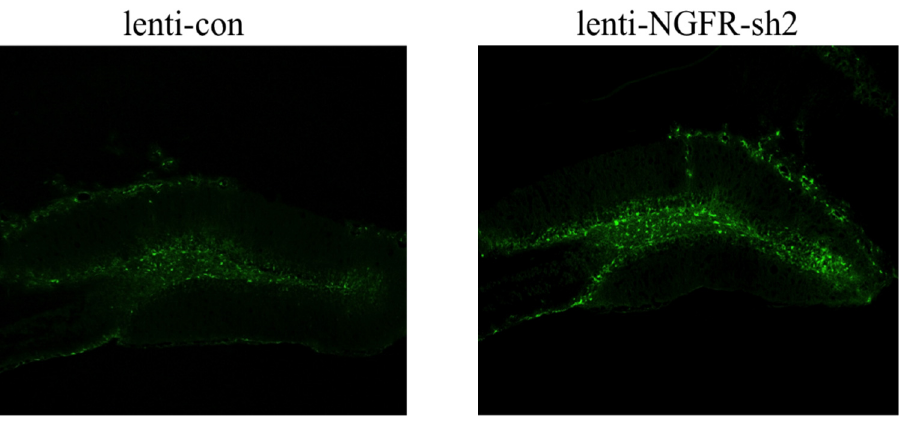
Figure 3. Down-regulation of NGFR in mouse hippocampus. ( A ) Lenti-NGFR-sh2 or control virus was injected into the dentate gyrus of adult mice. Two weeks after injection, extracts from hippocampus were immunoblotted. ( B ) One-way ANOVA of the protein levels after normalization to β -actin, data showed as means ± SEM, * p < 0.05.